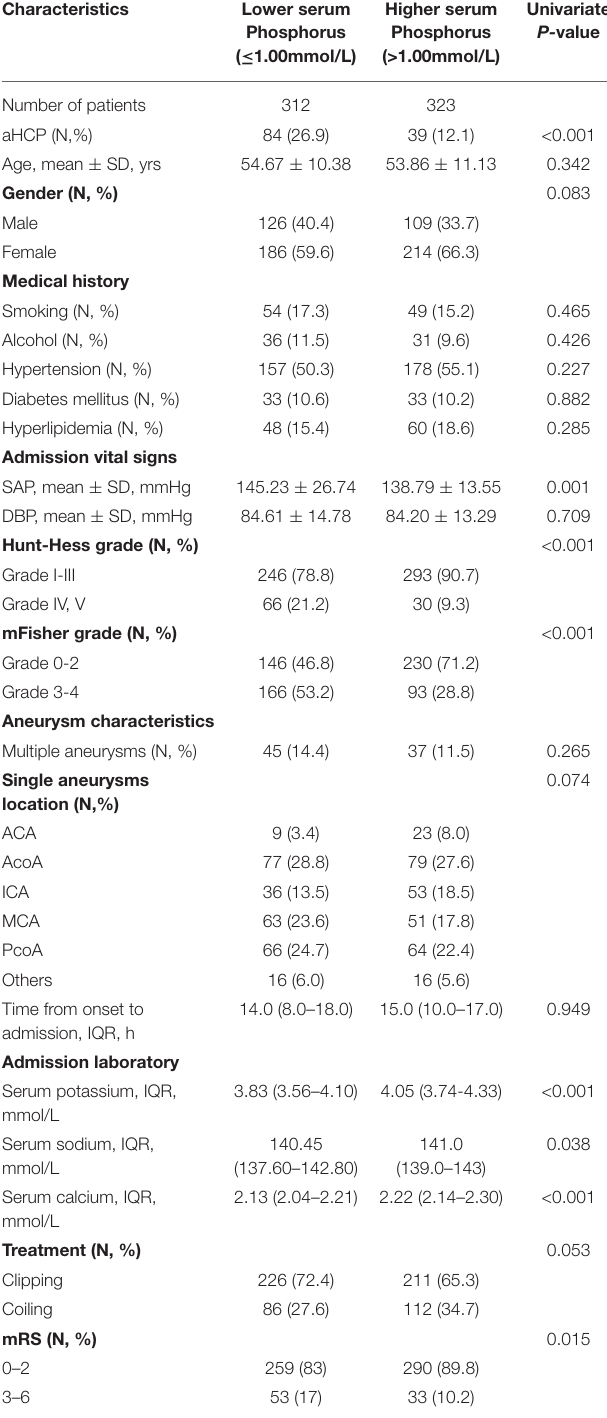
TABLE 3 | Patients’ demographics and baseline characteristics by sPi concentration. (the median level of sPi in all patients) have a worse prognosis than patients with a sPi level > 1.0 mmol/L ( Figure 4B ). In Characteristics Lower serum addition, the incidence of poor prognosis in aSAH patients with Phosphorus aHCP was higher than those without HCP. Figure 4C detailed the distribution of mRS scores for the two groups of patients. According to the ROC curve, the AUC of sPi level was 0.602